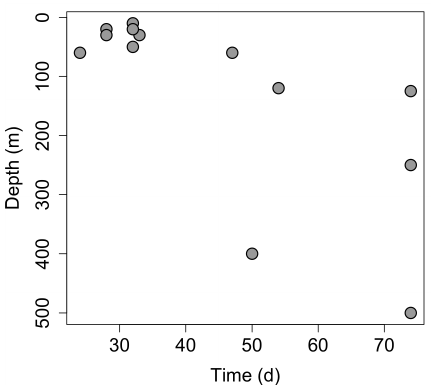
Figure 7. Depths at which the total particulate ( > 1µm) 210 Po / 210 Pb activity ratio was lower than unity vs. the time since the last bloom (data are presented in Table